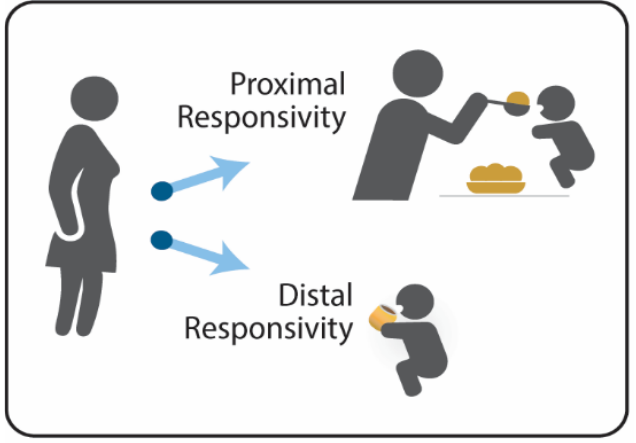
Figure 1. Modulating Between Proximal and Distal Responsivity.